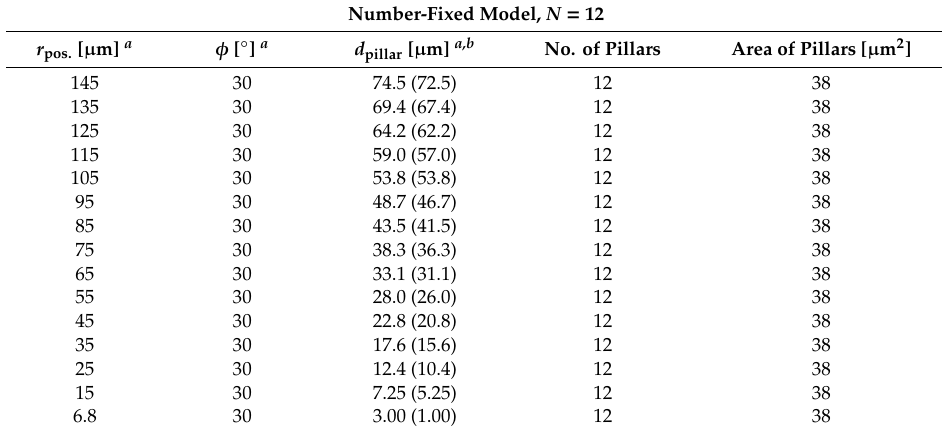
φ , and d a r pos. , pillar are denoted in Figure 3a. neighboring pillars ( d pillar − 2 × r pillar